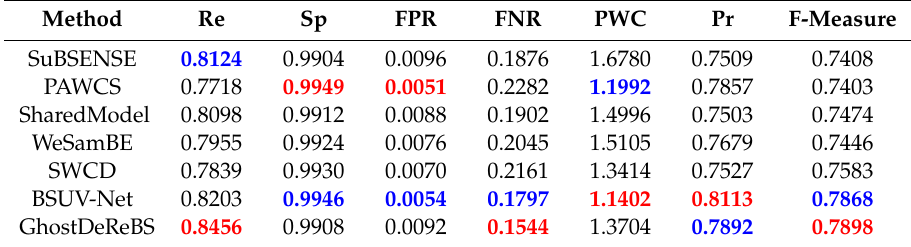
Table 7. Overall performance analysis of several the state-of-the-art methods on CDnet2014 Dataset.